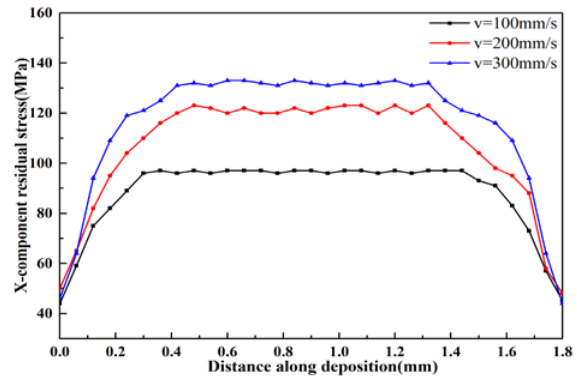
Fig. 5. Residual stress of sample with different scanning